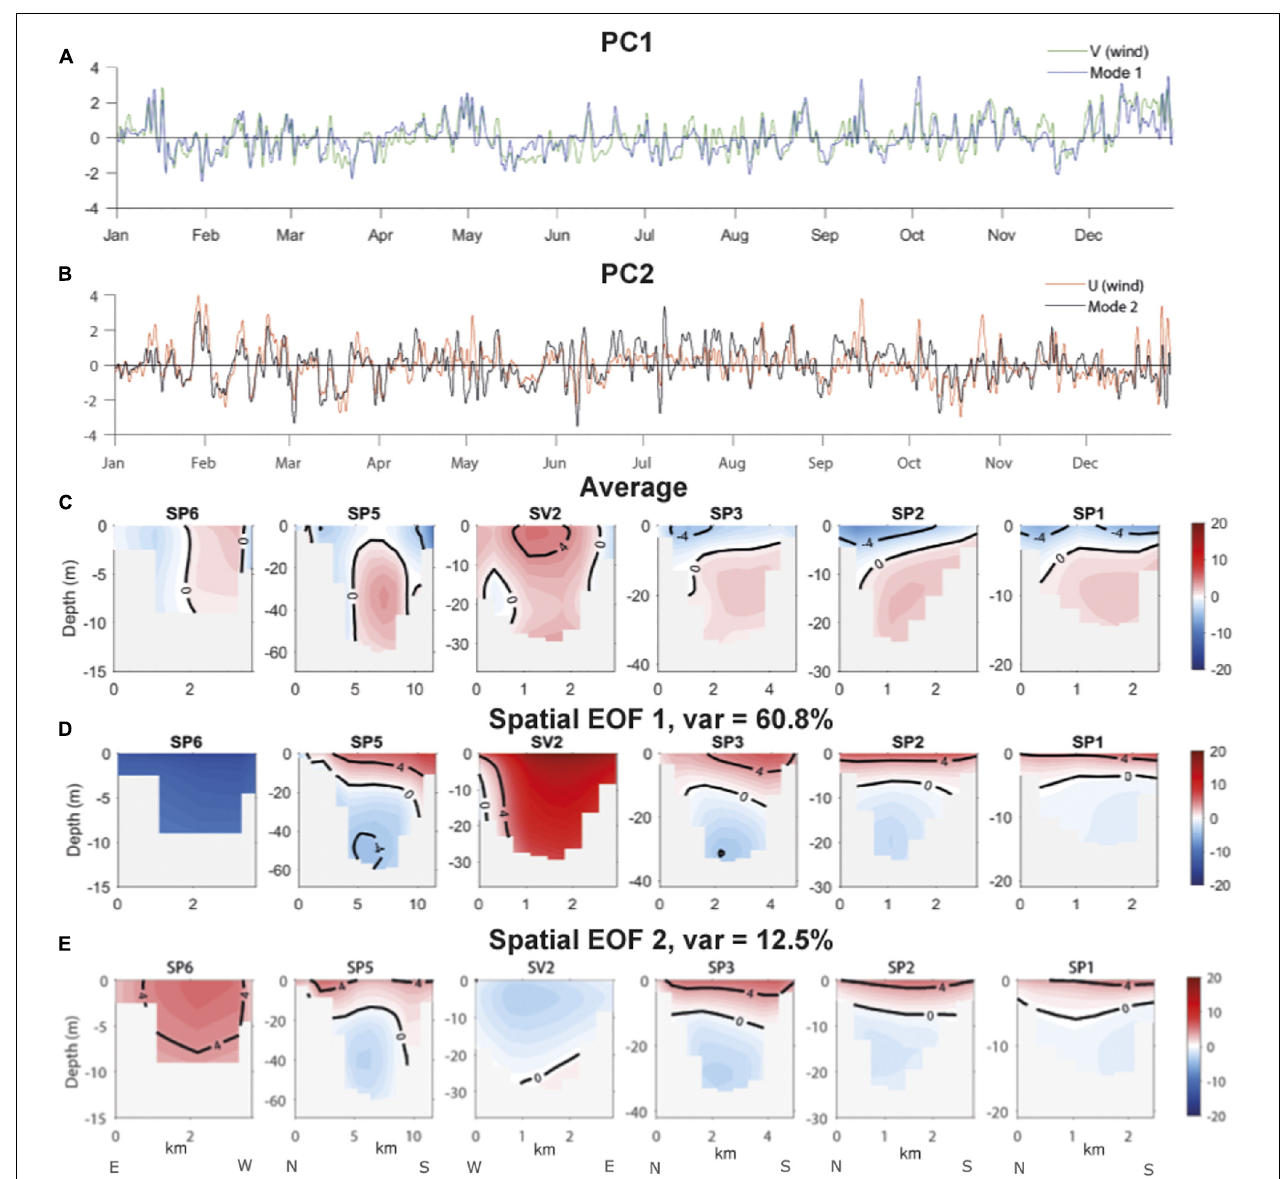
FIGURE 10 | EOF at cross-sections for normal subtidal velocity (cm/s). PC time series of (A) normalized mode 1 (blue) superimposed on the normalized meridional (V) wind component (green) located at the wind point in Figure 2 ; (B) normalized mode 2 (black) superimposed on the normalized zonal (U) wind component (red) located at the wind point in Figure 2 . (C) Time-averaged of normal subtidal velocity (cm/s) for the main cross-sections displayed in Figure 2 . Spatial (D) first and (E) second EOF structure of the same cross-sections. Red positive (blue negative) values indicate inflow (outflow). Direction of cross-sections is indicated by northerly (N), southerly (S), westerly (W) and easterly (E)